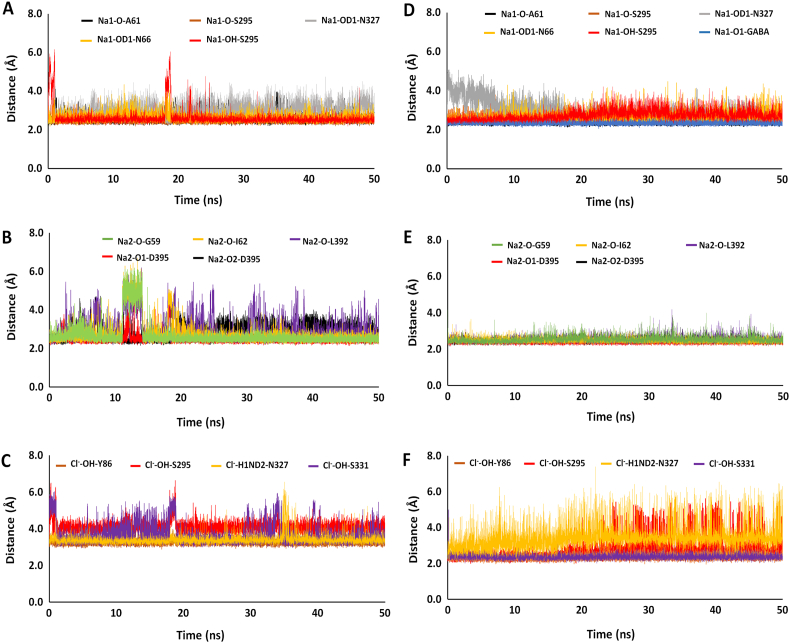
Distances between the (A) Na1 binding site residues, (B) Na2 binding site residues and (C) Cl− binding site residues of hGAT1 over the course of 50 ns simulation time in hGAT1outN1+2, C and in fully loaded complex in the presence of GABA i.e., hGAT1outG, N1+2, C in D, E and F.